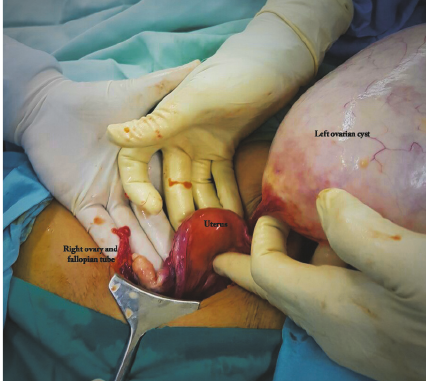
Figure 3: Healthy uterus, right fallopian tube, and